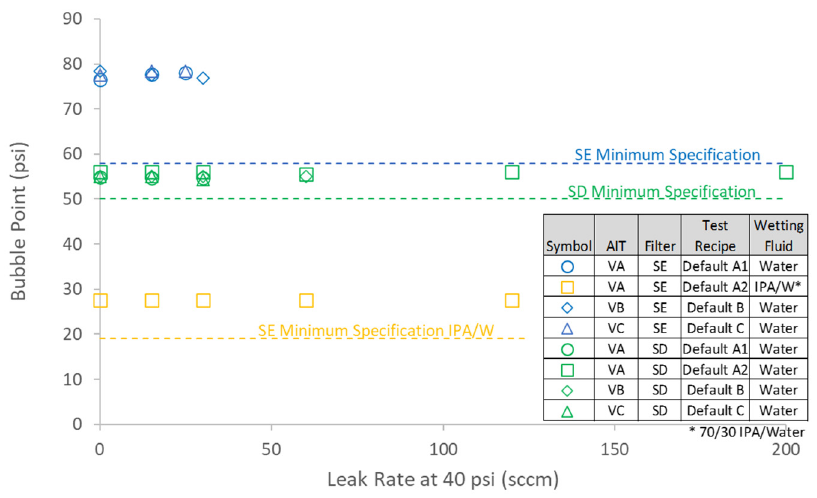
Figure 4. Effect of leak rate on reported bubble point. Default or vendor-recommended values were used for each AIT. used for each